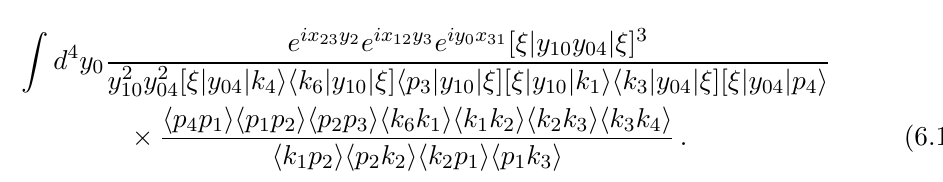
in the one-loop